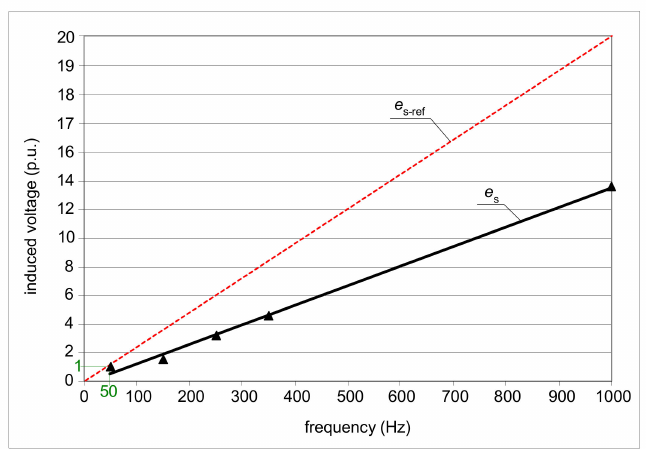
Figure 18. Variation (measured) in the induced secondary voltage e s of the A-type current sensor for the frequency range of the residual current f = 50–1000 Hz; e s-ref (dotted red line), reference line for an ideal current sensor (transformer).